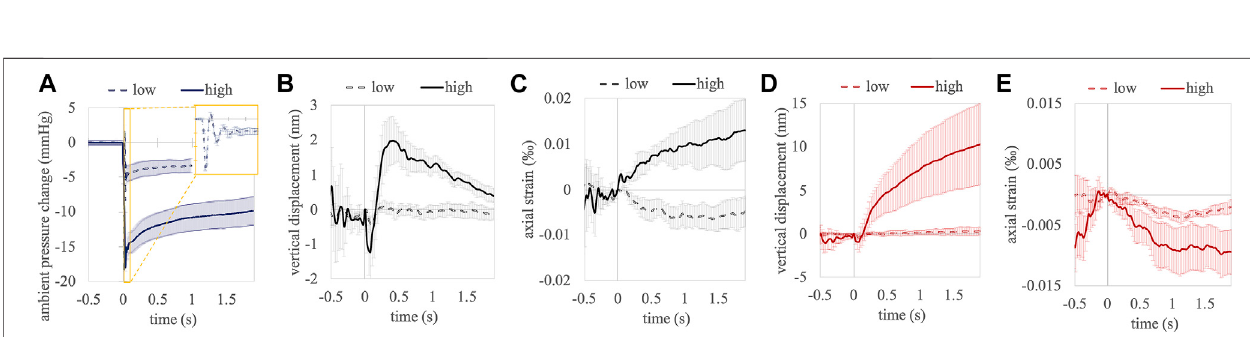
Frontiers in Bioengineering and Biotechnology |